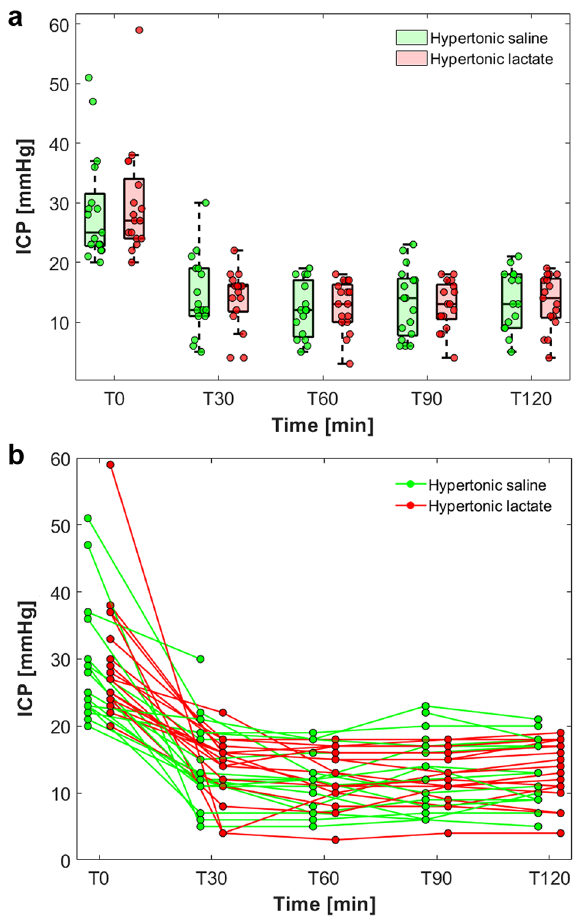
Figure 1. Effect of hypertonic saline and hypertonic lactate boluses on intracranial pressure (ICP) decrease. ( a ) Box-plots and scatter-plots illustrating ICP decrease over time from baseline vs. 30 (T30), 60 (T60), 90 (T90) and 120 (T120) minutes following hypertonic saline (in green) and hypertonic lactate (in red). ( b ) Spaghetti plot showing the individual patient trajectories for hypertonic saline (in green) and hypertonic lactate (in